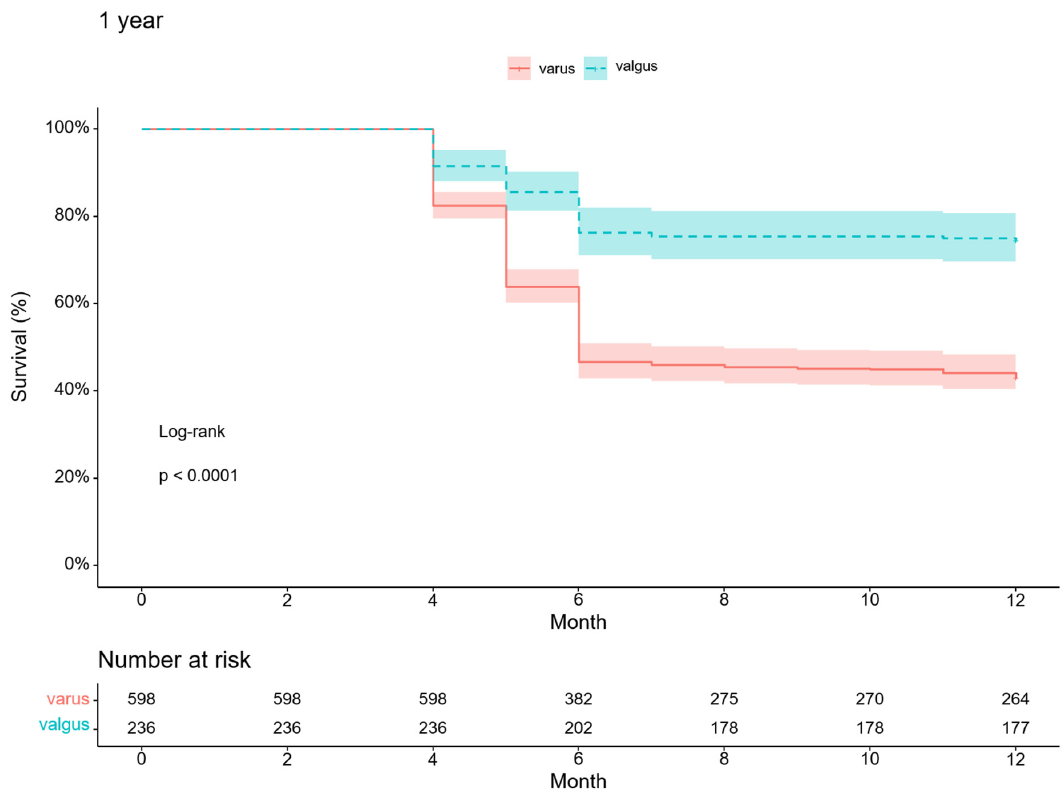
Figure 4. One-year Kaplan–Meier survivorship curve for varus and valgus arthritic knees.